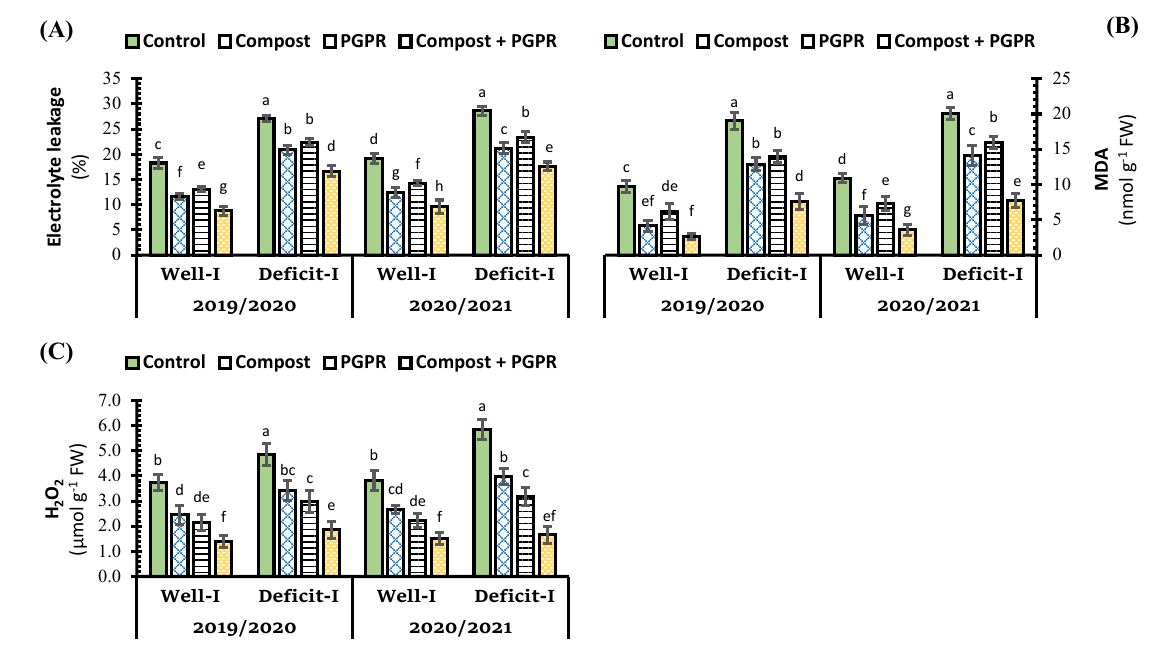
Figure 3. Influence of soil amendment with compost and plant growth-promoting rhizobacteria (PGPR) on ( A ) electrolyte leakage percentage, ( B ) malondialdehyde (MDA) concentration, and ( C ) hydrogen peroxide (H 2 O 2 ) concentration in the leaves of wheat plants grown in salt-affected soil and deficit irrigation in contrast to well irrigation. The error bars present the values of standard deviation. According to Duncan’s multiple range test, the same lower-case letters above columns are not significantly different ( p < 0.05). The antioxidant enzymes superoxide dismutase (SOD), peroxidase (POD), and cata- lase (CAT) activities in the leaves of wheat plants growing under deficit irrigation are depicted in Figure 4 in relation to compost and/or PGPR applications. In comparison to sulted in increased SOD, CAT, and POD, which increased by 51.3%, 24.8%, and 27.7%,